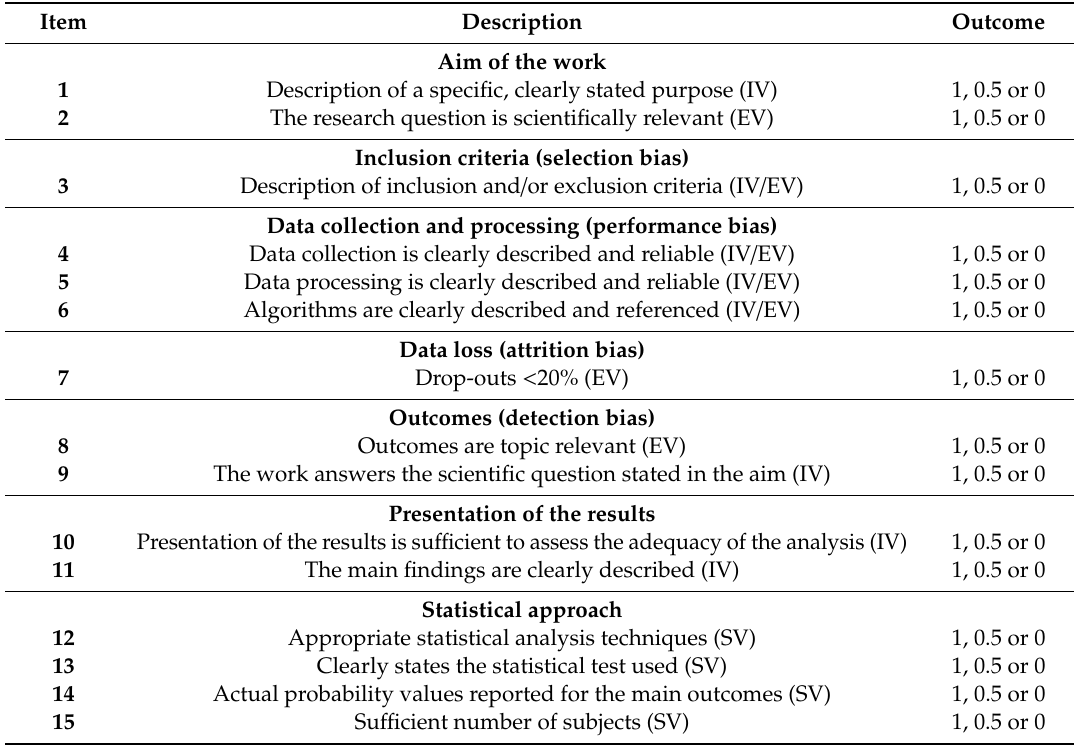
Table 1. Quality assessment checklist of internal, external and statistical validity (IV, EV and